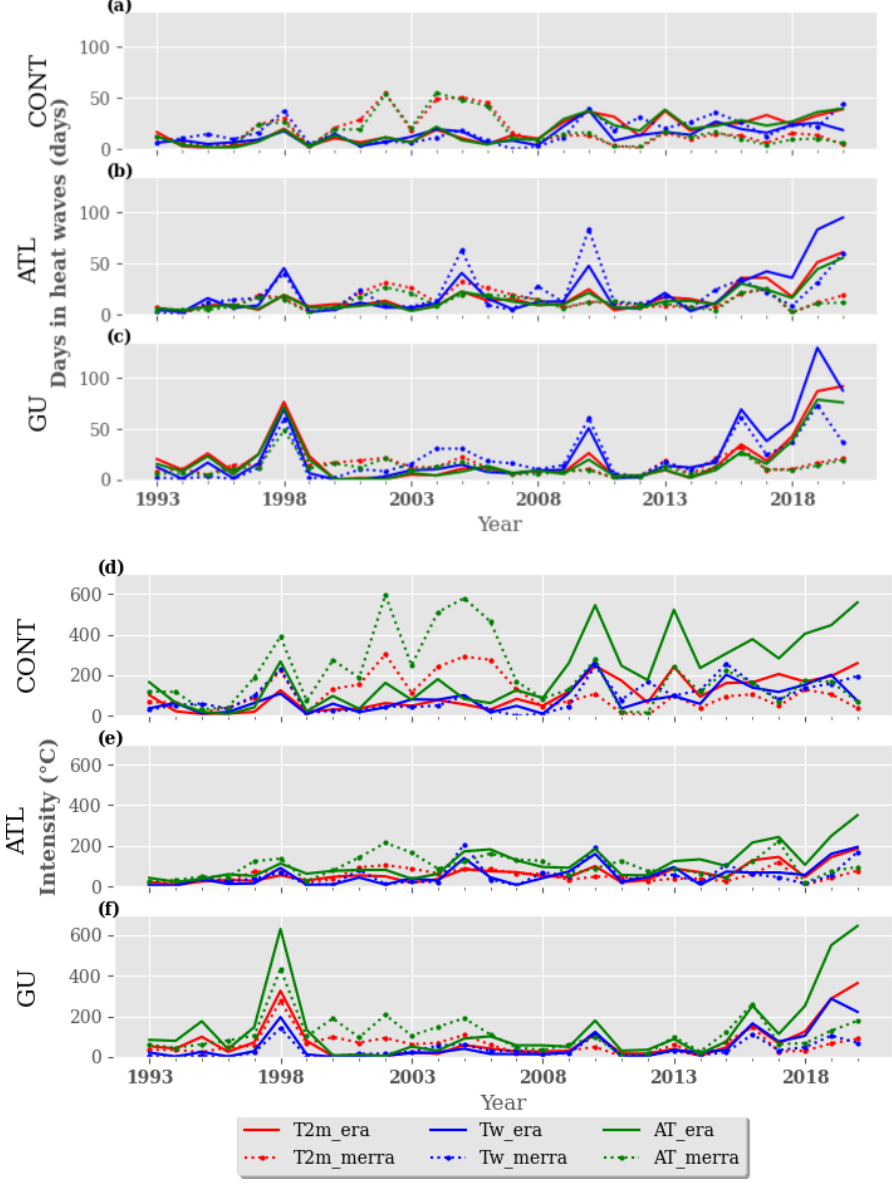
Figure 7. Interannual variability of heat wave characteristics using maximum values of T 2m , T w and AT for (a–c) duration and (d–f) intensity. The detection of heat waves is done using the climatological daily 90th percentile as a threshold over the period, and the characteristics of heat waves are computed in the three regions: (a, d) CONT, (b, e) ATL and (c, f) GU. The solid and dashed red/blue/green lines represent the evolution of heat wave characteristics using T 2m / T w /AT from ERA5 and MERRA respectively. The x and y axes represent the duration and intensity of heat waves and the time in year